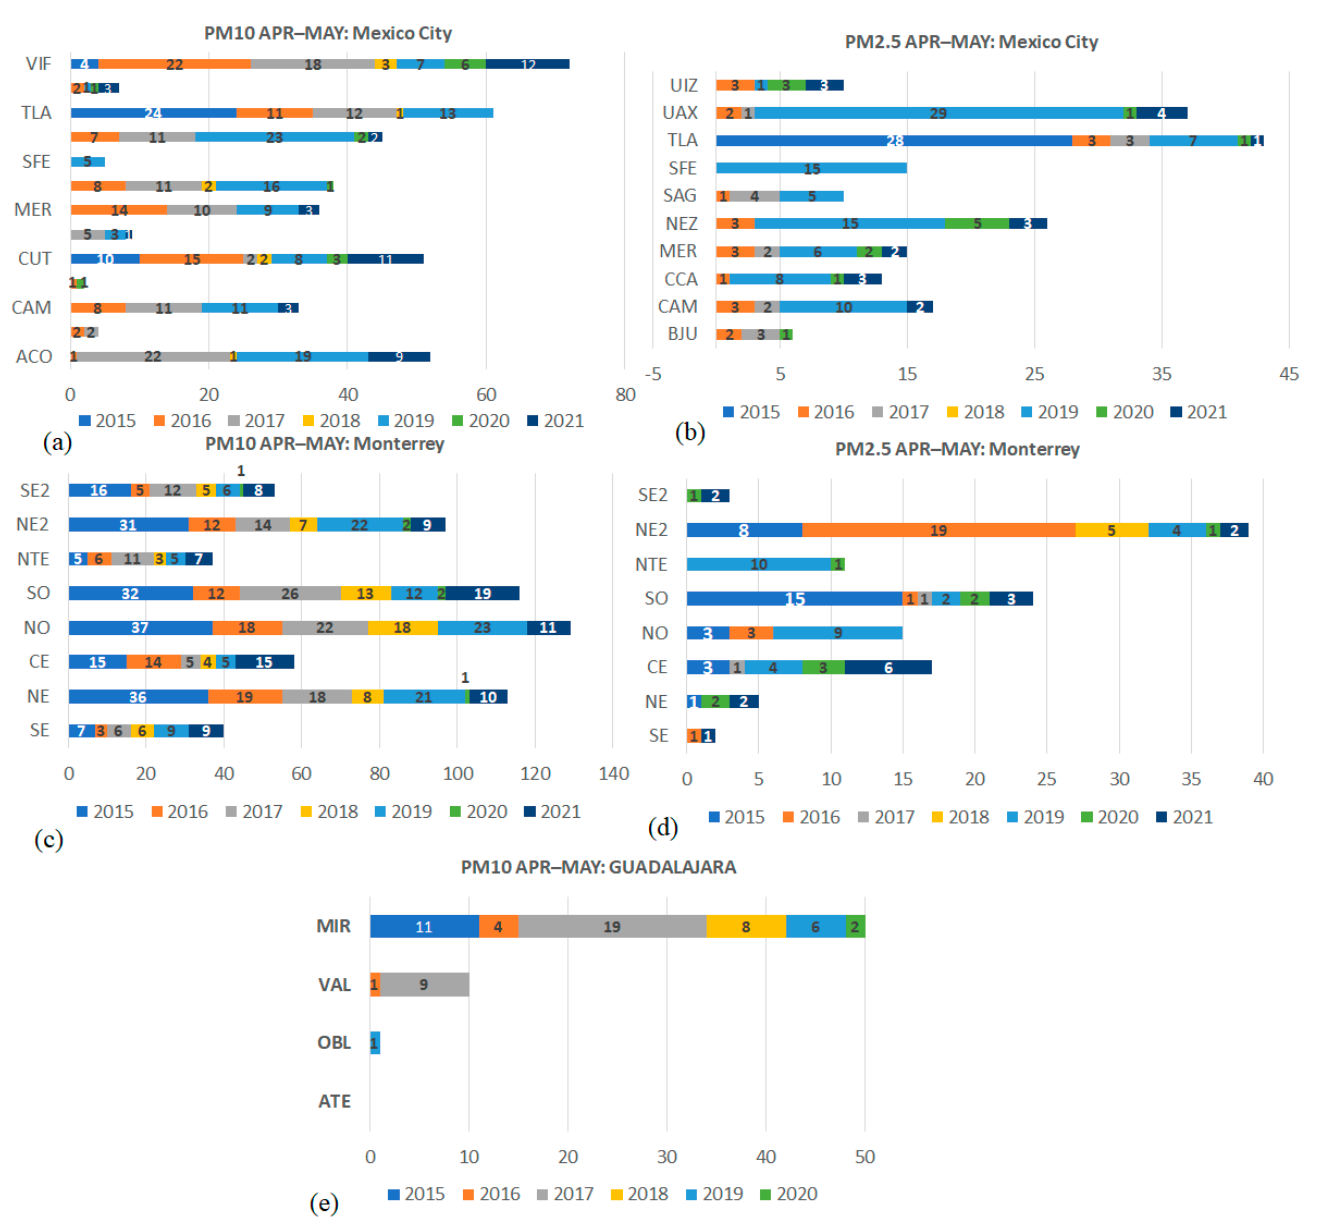
Figure 6. Number of days that exceeded the PM 10 and PM 2.5 limits in Mexico City ( a , b ). Number of days that exceeded the PM 10 and PM 2.5 limits in Monterrey ( c , d ). Number of days that exceeded the PM 10 limits in Guadalajara ( e ). In all cases, the period is April and May